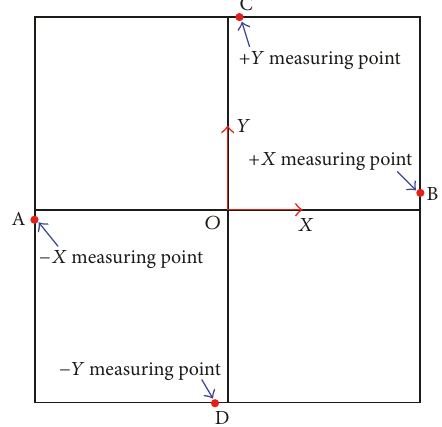
Figure 10: Distribution of acceleration measuring